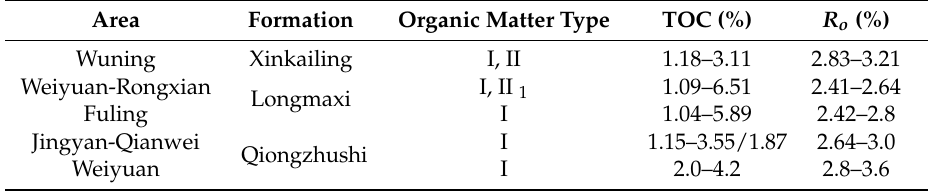
Table 1. Comparison of the organic geochemical parameters between the Xinkailing-formation shale in Wuning and the Lower Paleozoic-formation shale in middle-upper Yangtze area. (Data from [17,32–34]). Area Formation Organic Matter Type Wuning